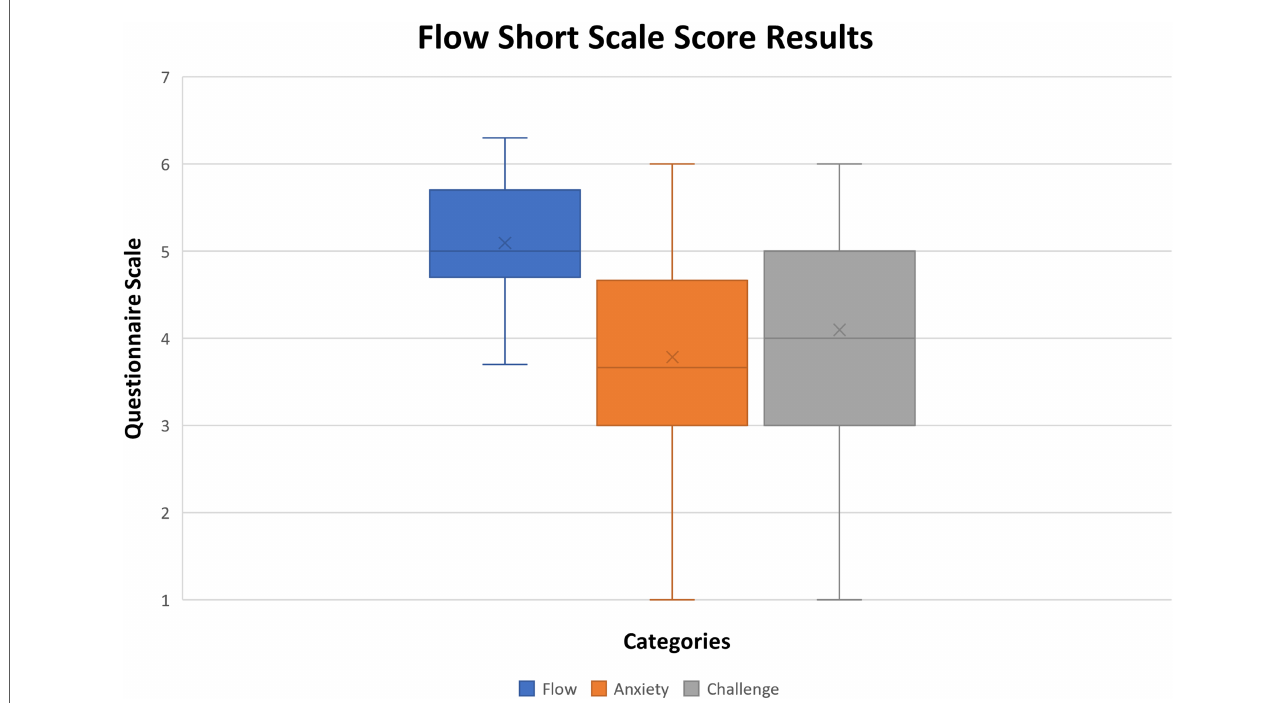
FIGURE 10 Boxplot chart of fl ow short scale score results (x stands for mean value, rectangle upper and lower quartile with at least 50% of values, whiskers represent the 0th and fourth quartile when there are